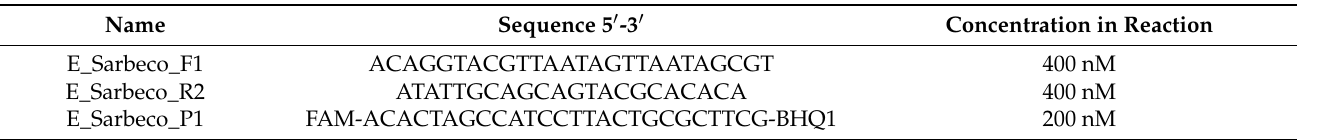
Table 1. Primers and probe